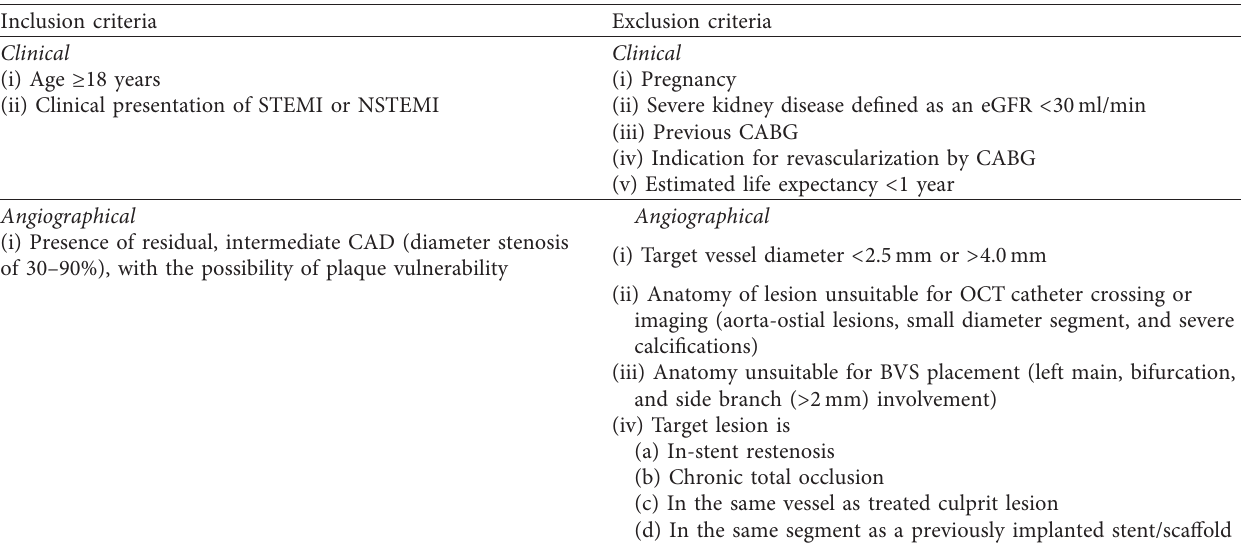
Table 1: Inclusion and exclusion